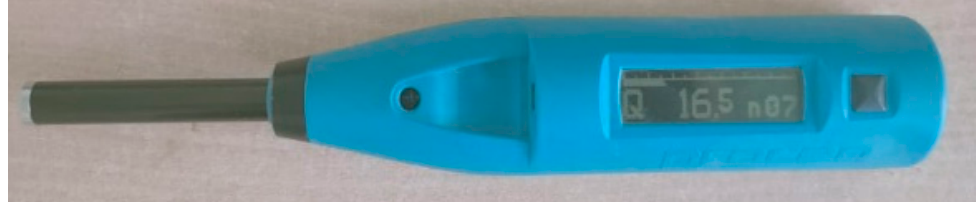
Figure 2. Rebound hammer equipment .